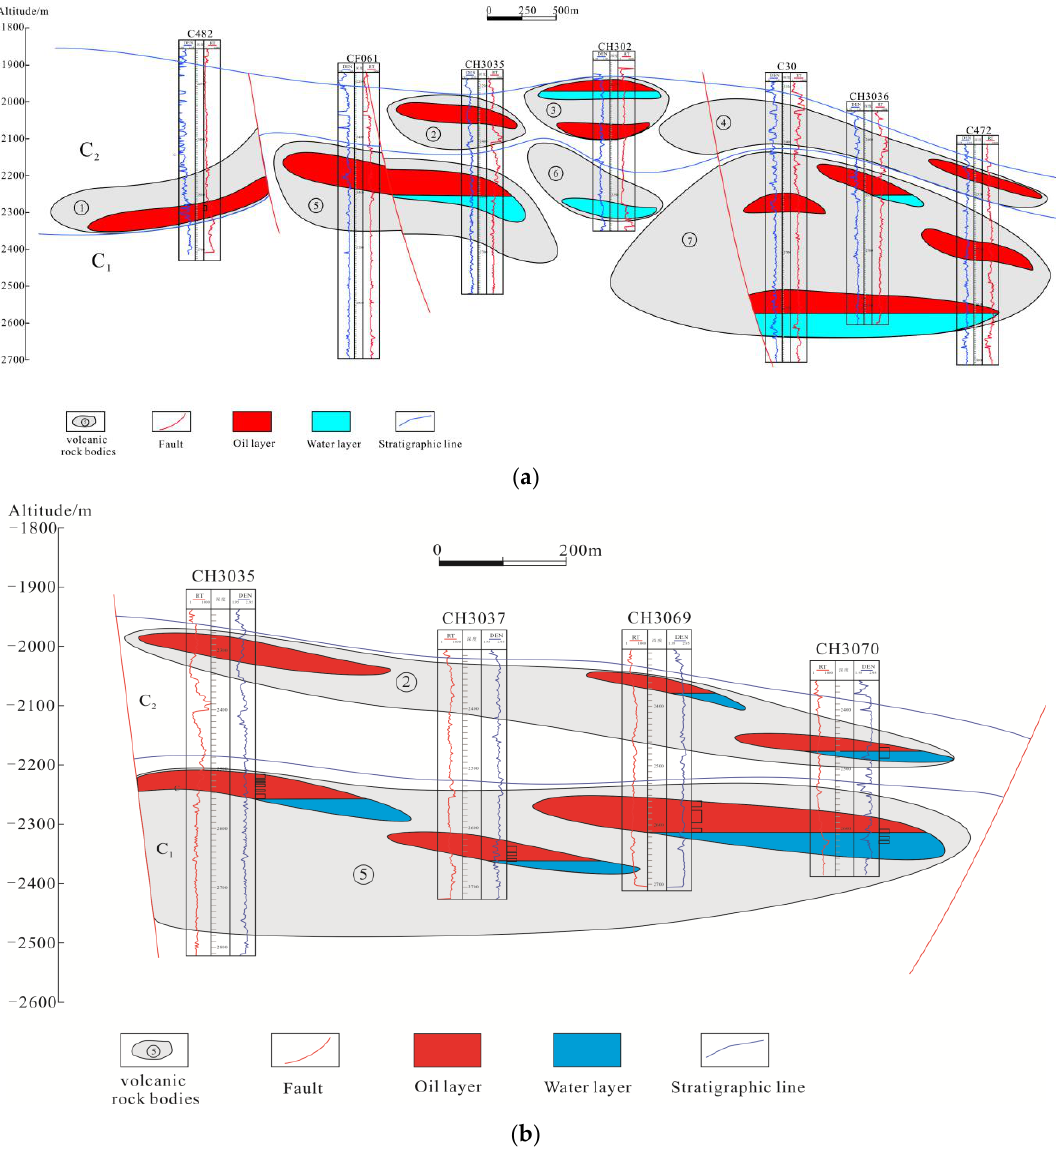
Figure 4. Profiles of the Carboniferous volcanic reservoir in the Chepaizi Uplift. ( a ) Reservoir profile cross Wells C482-CF061-CH3050-C472; ( b ) Reservoir profile cross Wells CH3035-CH3037-CH3069-